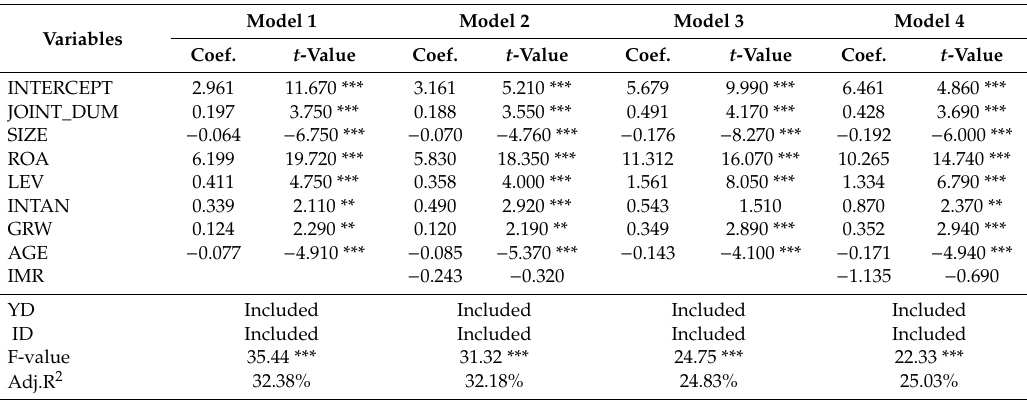
Table 5. Analysts’ cash flow forecasts issuance and firm